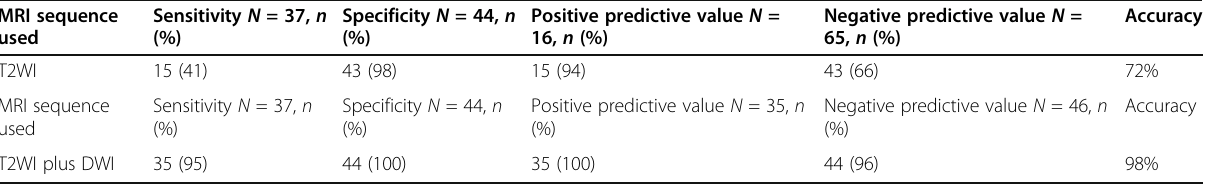
Table 4 HR T2WI only and HR T2WI plus DWI to differentiate non muscle invasive from muscle invasive bladder cancer MRI sequence